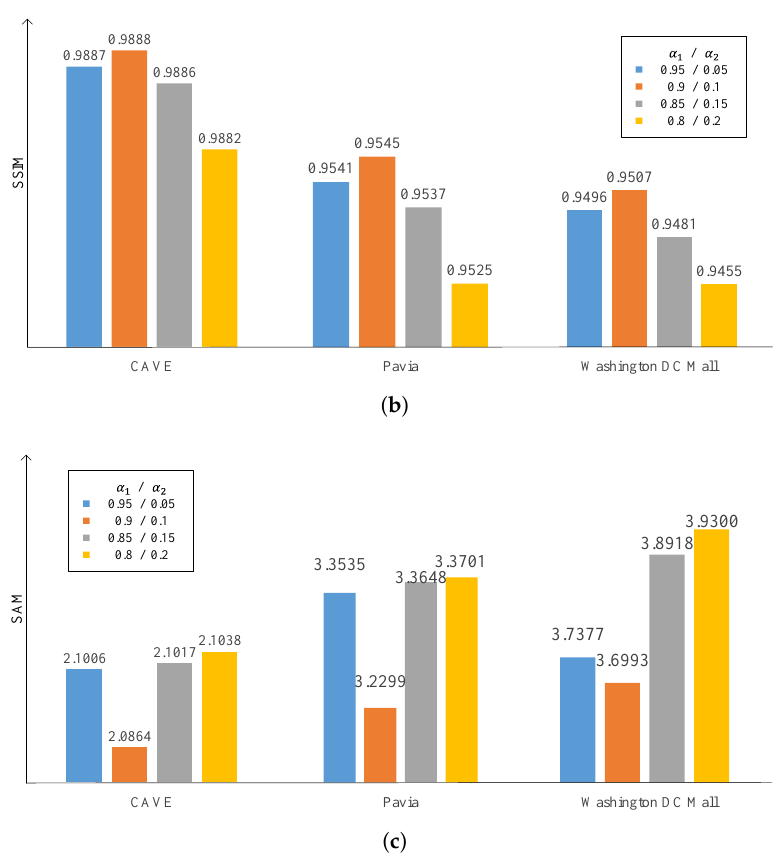
Figure 4. Variation of the ( a ) PSNR, ( b ) SSIM, and ( c ) SAM with different α 1 and α 2